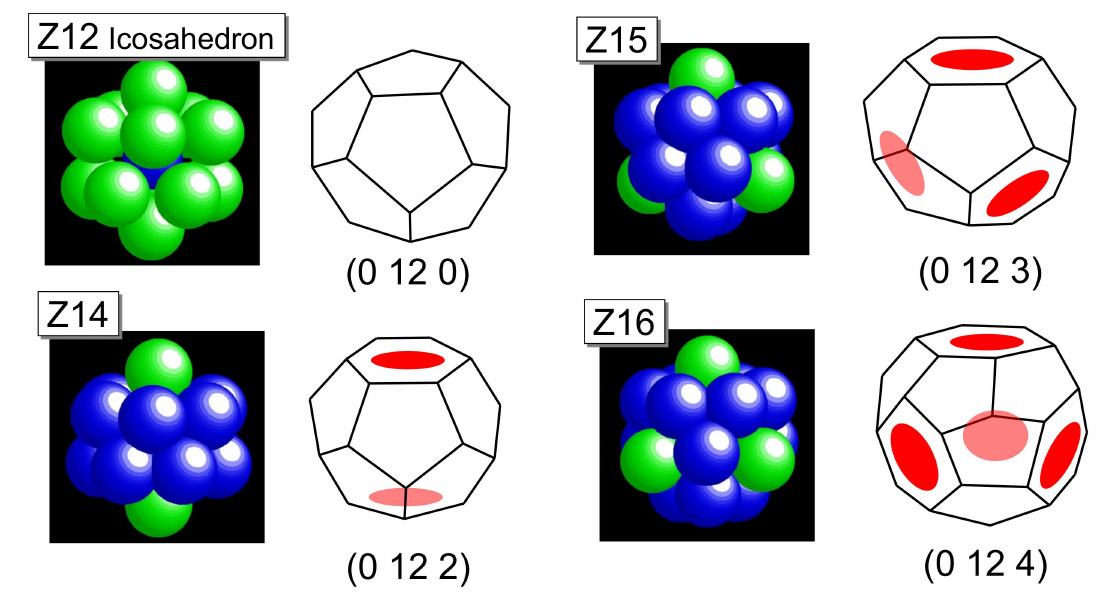
Figure 1. Four different types of Frank–Kasper clusters: Z12, Z14, Z15, and Z16, and their Voronoi polyhedra found in the glassy A-B phases. The green and blue spheres denote the A and B atoms, respectively. The six-edged Voronoi faces (hexagons) are indicated by the red